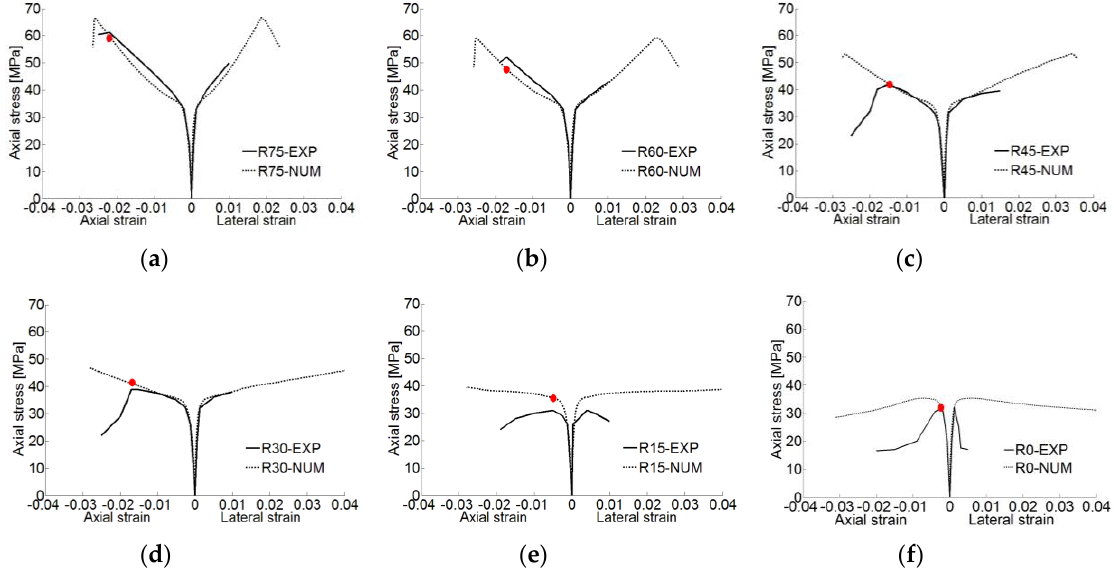
Figure 8. CFRP-confined specimens: uniaxial stress-strain curves : ( a ) R75, ( b ) R60, ( c ) R45, ( d ) R30, ( e )